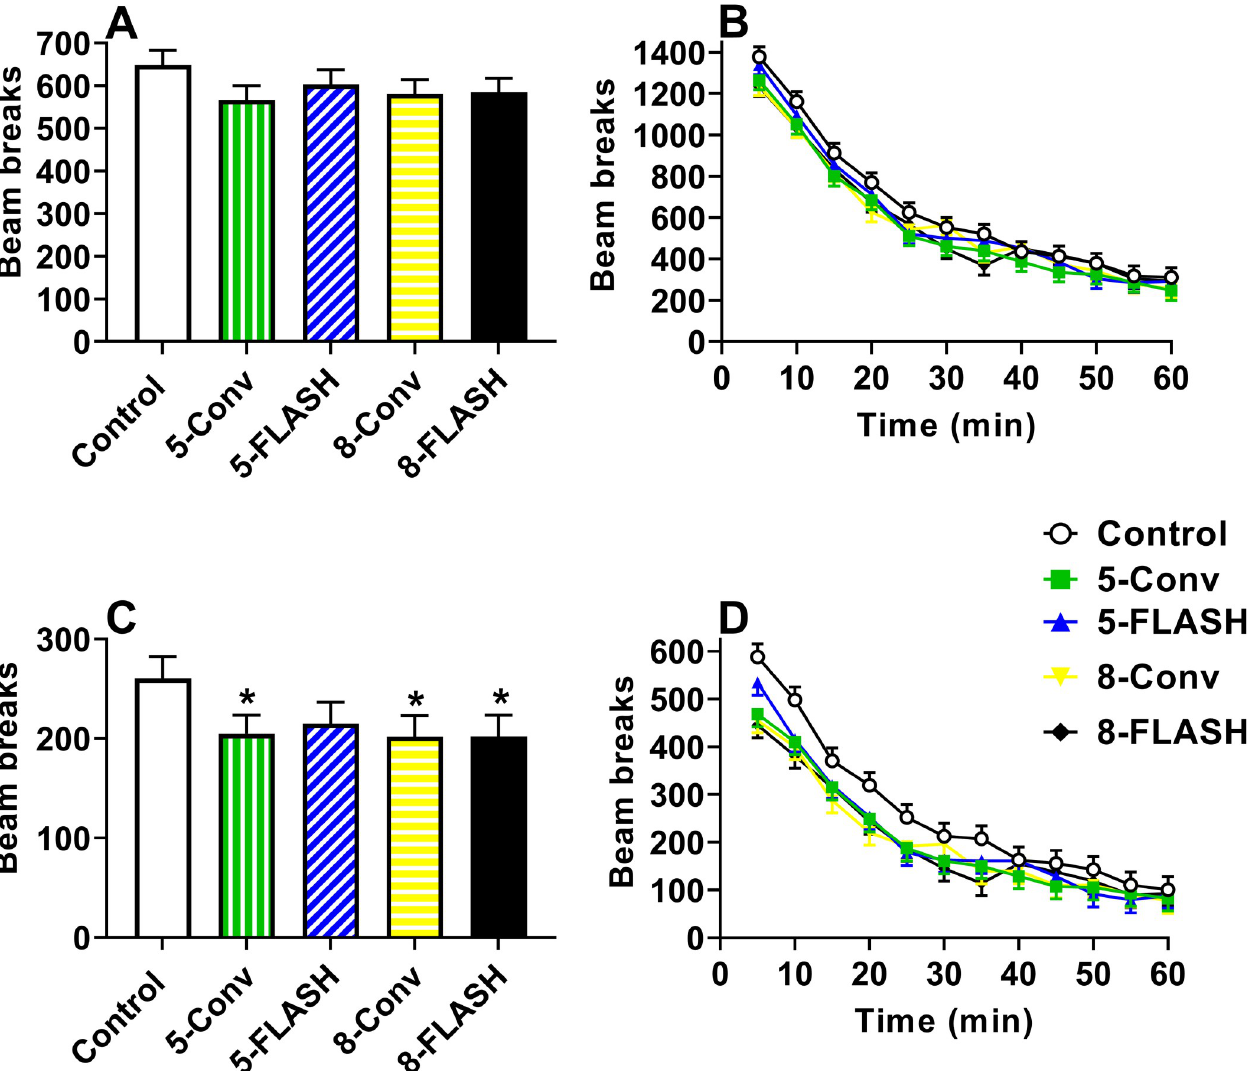
Fig 3. Locomotor activity [beam breaks (mean ± SEM)] of proton irradiated and control rats. A . Effects on ambulation by exposure, averaged across sex and test interval (time). No differences in irradiated groups compared with controls. B. Ambulation by test interval with males and females combined. C. Effects on center ambulation by exposure, averaged across sex and time. All irradiated groups with the exception of the 5-FLASH group had reduced center ambulation compared with controls. D. Center ambulation by test interval with males and females combined. � p < 0.05 compared with controls. N = 19/sex/ exposure except control male = 17 and 5-FLASH male and female =